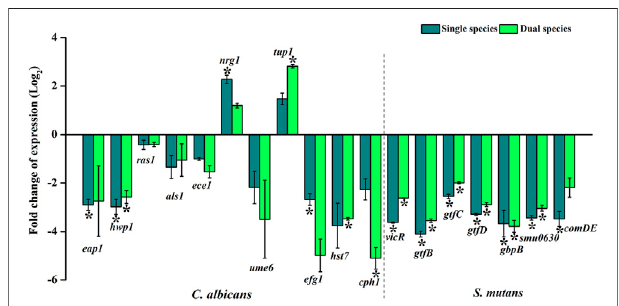
FIGURE 7 | Gene expression pro fi ling of candidate genes associated with virulence and pathogenesis of C. albicans and S. mutans under single and dual species state. Under the in fl uence of thymol, C. albicans genes that are responsible for bio fi lm formation, hyphal and fi lamentous development,adhesins,andmorphologicalphenotypicswitchingarefoundto bedownregulated.Negativetranscriptionalregulatorsof fi lamentationsuchas nrg1 and tup1 were found to be upregulated. S. mutans genes that are allied with bio fi lm formation, competence, glucan synthesis, which mediates interaction between C. albicans and S. mutans , is downregulated by the impact of thymol. Downregulation of virulence genes validates the anti- infective ef fi cacy of thymol. Error bars represent standard deviations from the mean and * indicates signi fi cance p < 0.05.